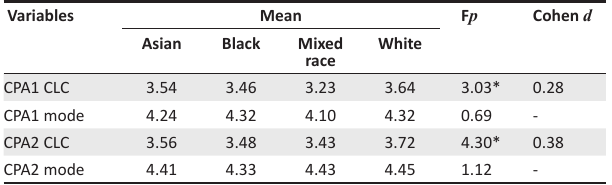
TABLE 5: Results of analysis of variance: Significant mean differences for race